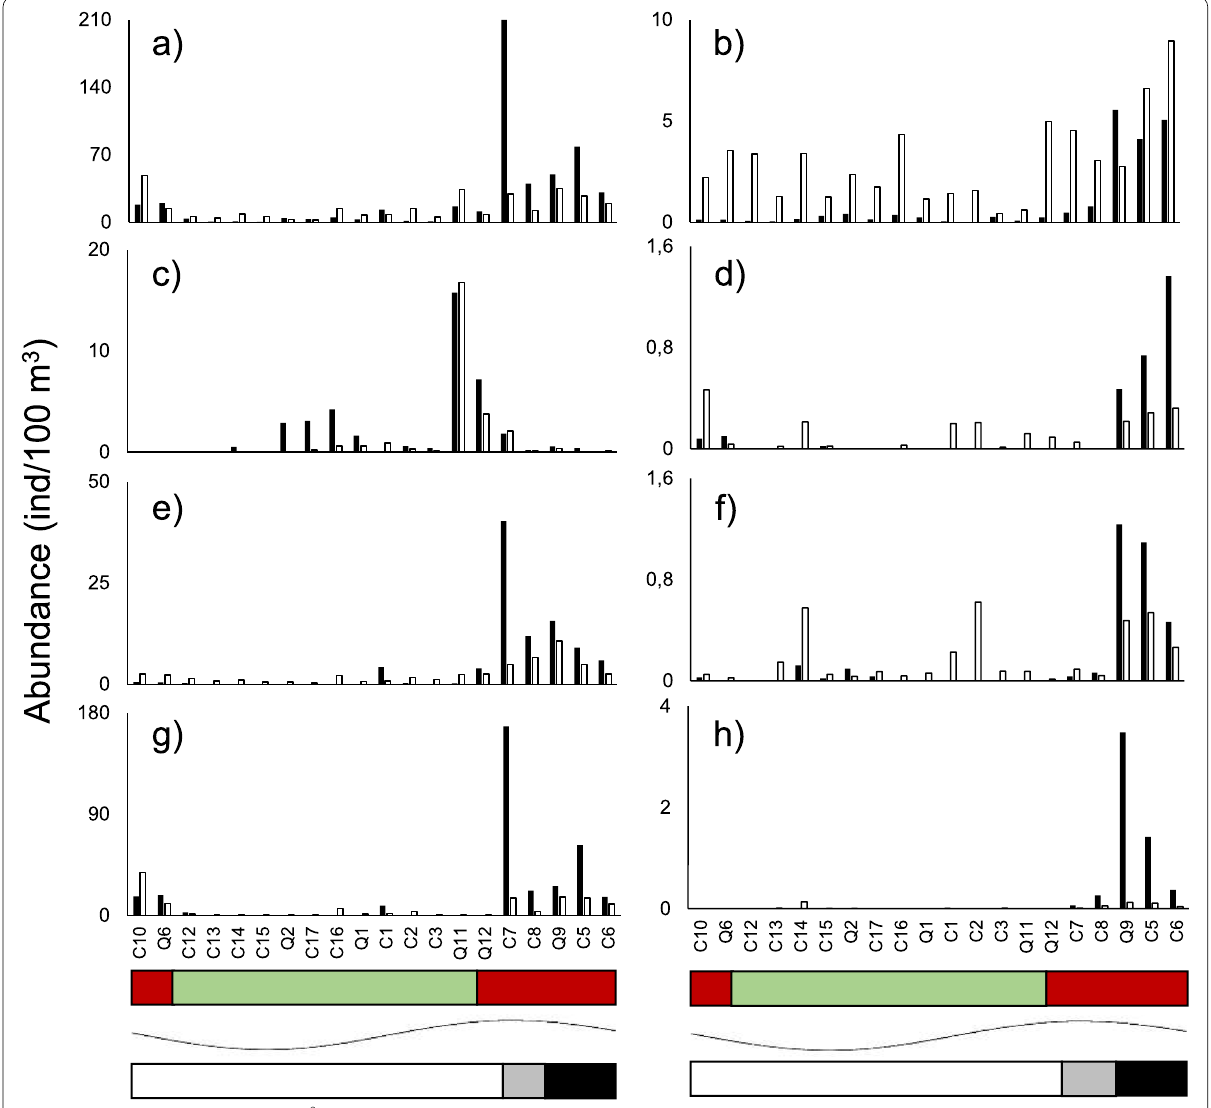
Fig. 7 Total abundance (Ind 100 m − 3 ) of ( a ) holoplankton and ( b ) meroplankton at each sampled site in Caucahué Channel. The most representative holoplankton taxa are shown in ( c , e and g ): c hyperiidae, e Chaetognatha and g Metridia sp. The most representative meroplankton taxa are shown in ( d , f and h ): d Callianassa sp., f Caridea sp, h Pagurus sp. Black bars correspond to samples collected in the surface stratum (0.1 to 0.2 m depth) and white bars to those collected in the deeper stratum of the water column (10 to 15 m depth). The horizontal black and white thick bars indicate the time of the day when sampling was conducted: white The colored thick bar shows the section of the channel where the samples were collected. Red section of the channel. Tidal cycle is represented by a black continuous line at the bottom of the